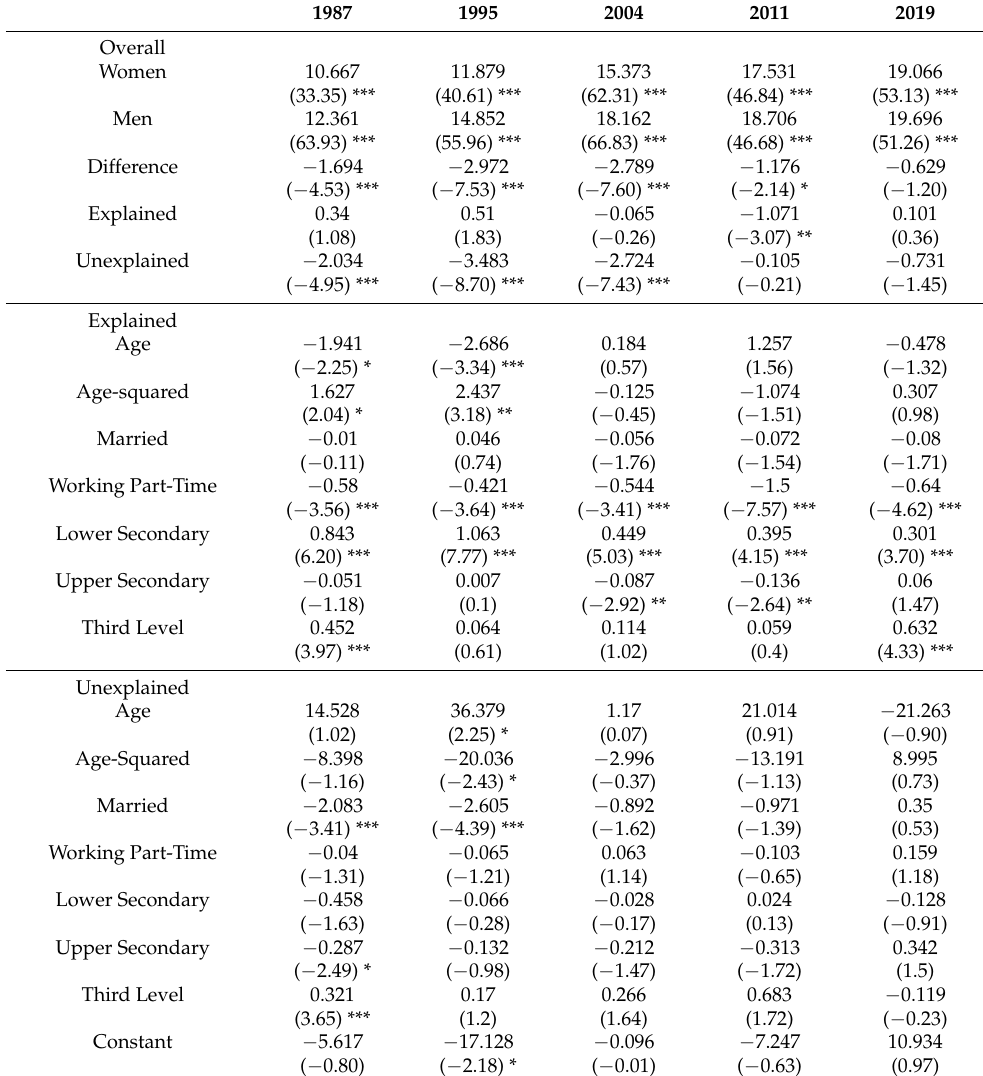
Table A6. Coefficient estimates and standard errors from RIF regressions for selected years (50th